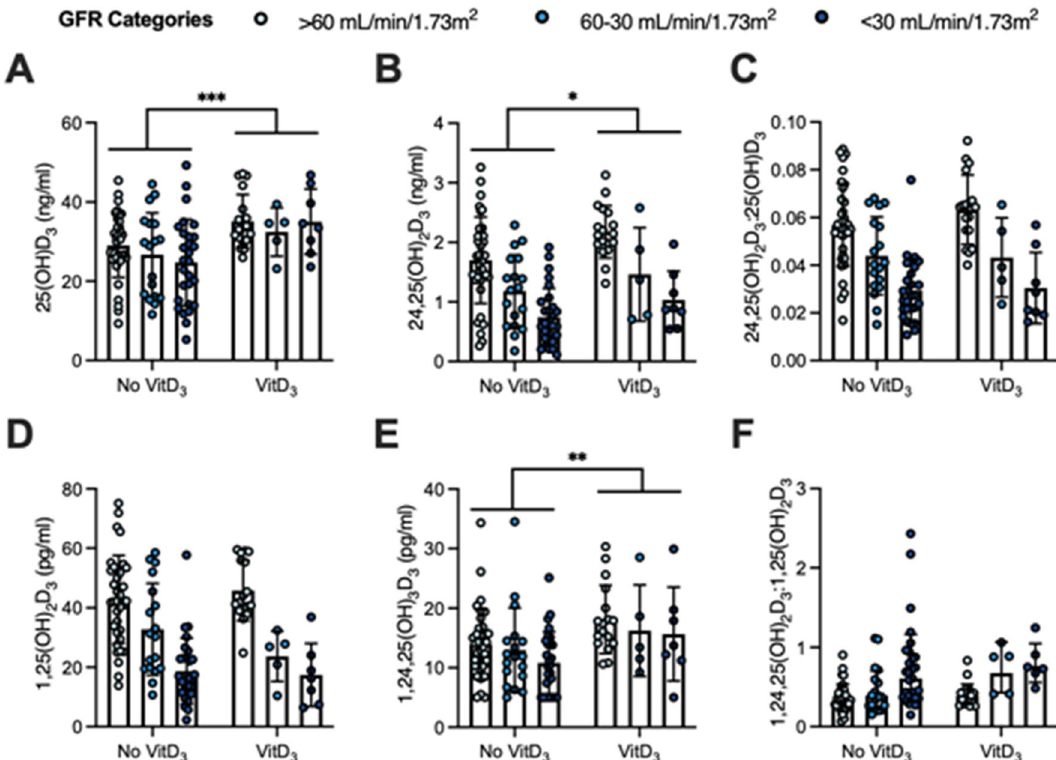
Figure 2. Vitamin D metabolites separated by cholecalciferol use delineated by measured GFR. ( A ) 25(OH)